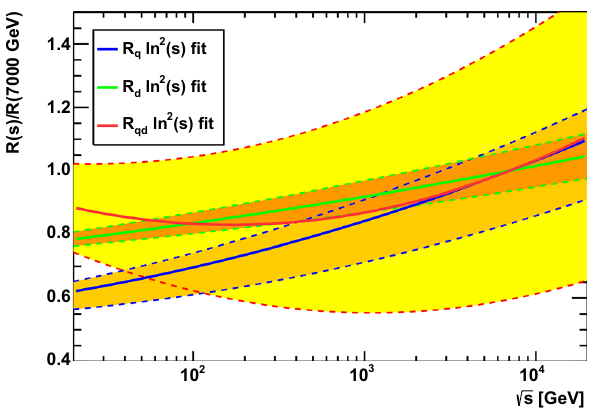
Fig. 20 The scaled energy dependence of the ReBB model parameters by the parameter values at 7 TeV. The original squared logarithmic excitation functions of the parameters are presented in Ref. [42]. The lower limit of the H ( x ) scaling is pushed further down to about 500 GeV, if the correlations between the parameters R q ( s ) , R d ( s ) and R qd ( s ) are neglected